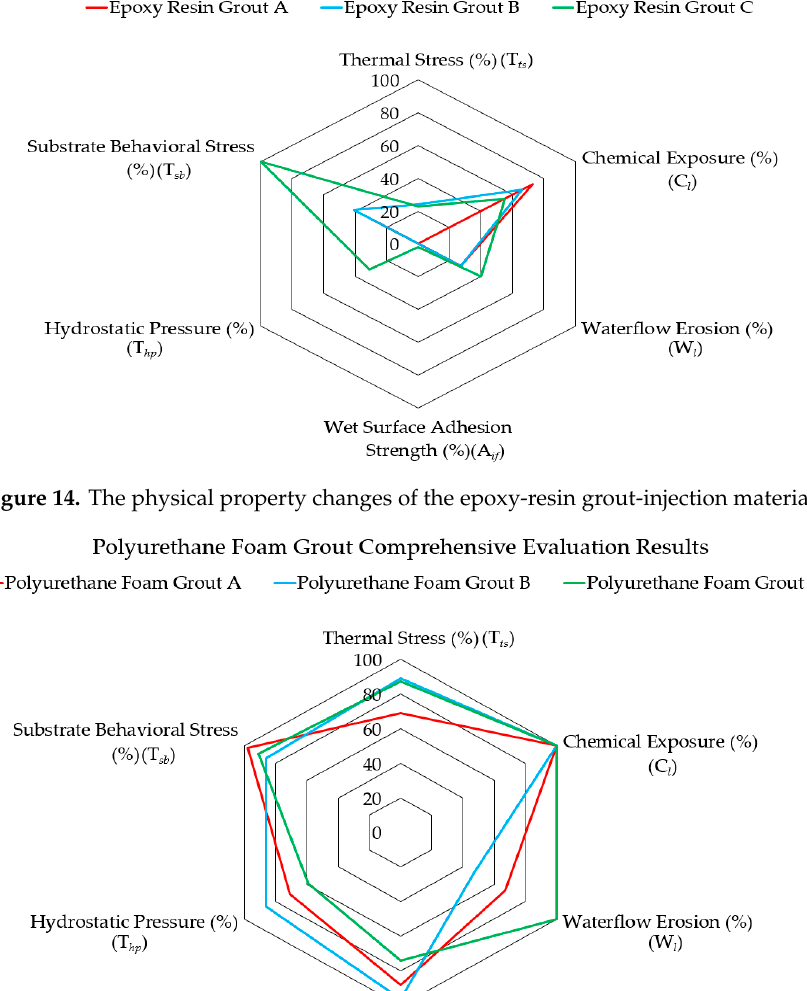
Figure 15. The physical property changes of the polyurethane-foam grout-injection material.